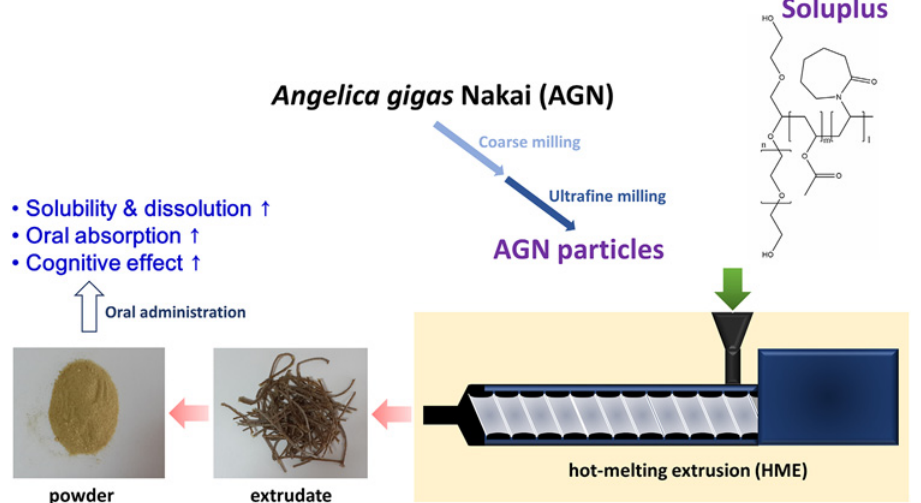
Fig 1. Scheme of developing AGN-based solid formulations by HME